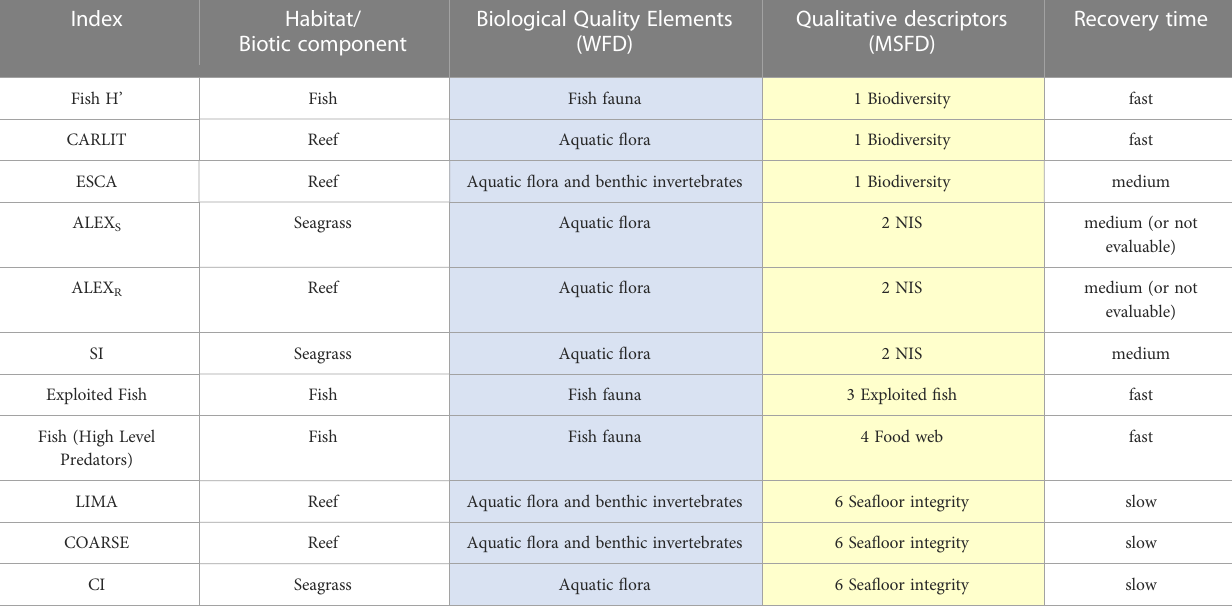
TABLE 1 List of the indices adopted in the present study and their corresponding Biological Quality Elements (BQEs) and qualitative descriptors according to the European